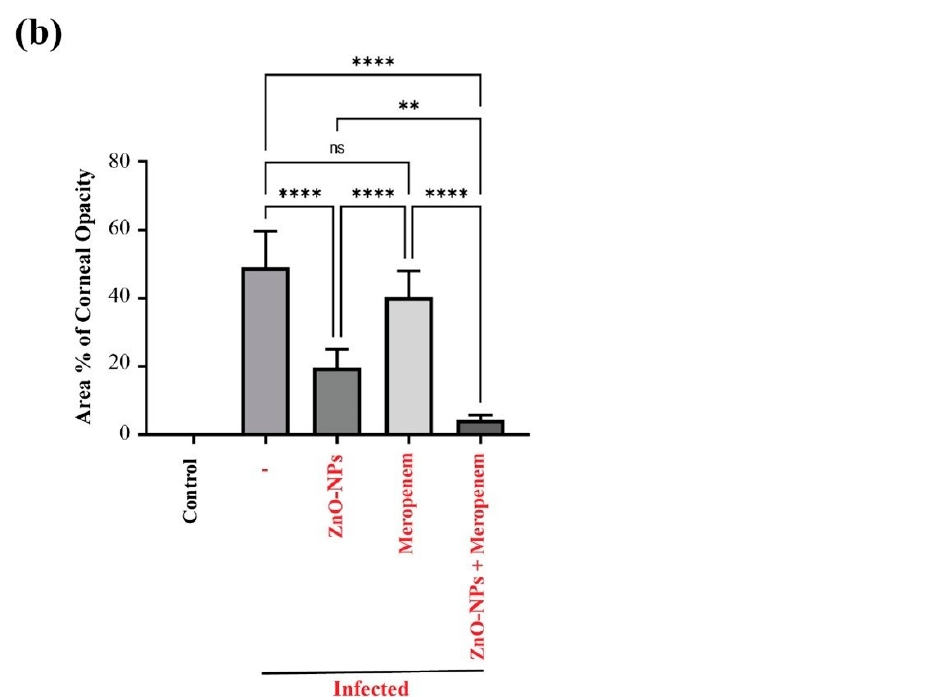
Figure 4. ZnO-NPs and meropenem mixture protects the rat cornea against pseudomonas-induced keratitis. ( a ) The Imagej-processed images of P. aeruginosa -infected eyes from different groups indicating focal lesions and corneal opacity (black areas), which represent a direct measure of the infection intensity. ( b ) Effect of meropenem and ZnO-NPs on the Area % of corneal opacity. Data are presented as Mean ± Standard Deviation (SD). ** p ≤ 0.01; **** p ≤ 0.0001.